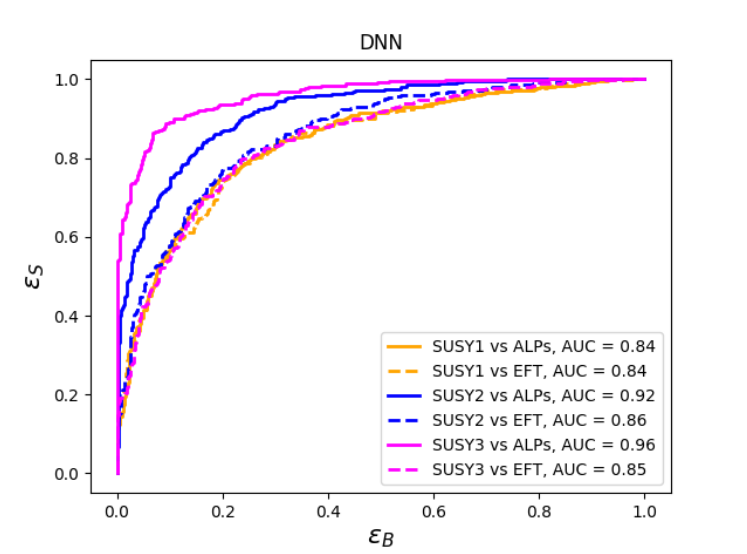
Figure 9: ROC curves (DNN with 2D histograms, r = 20) for SUSY WIMP benchmarks versus other signals, for the monojet data set (parton-level) with 50K events are used for each